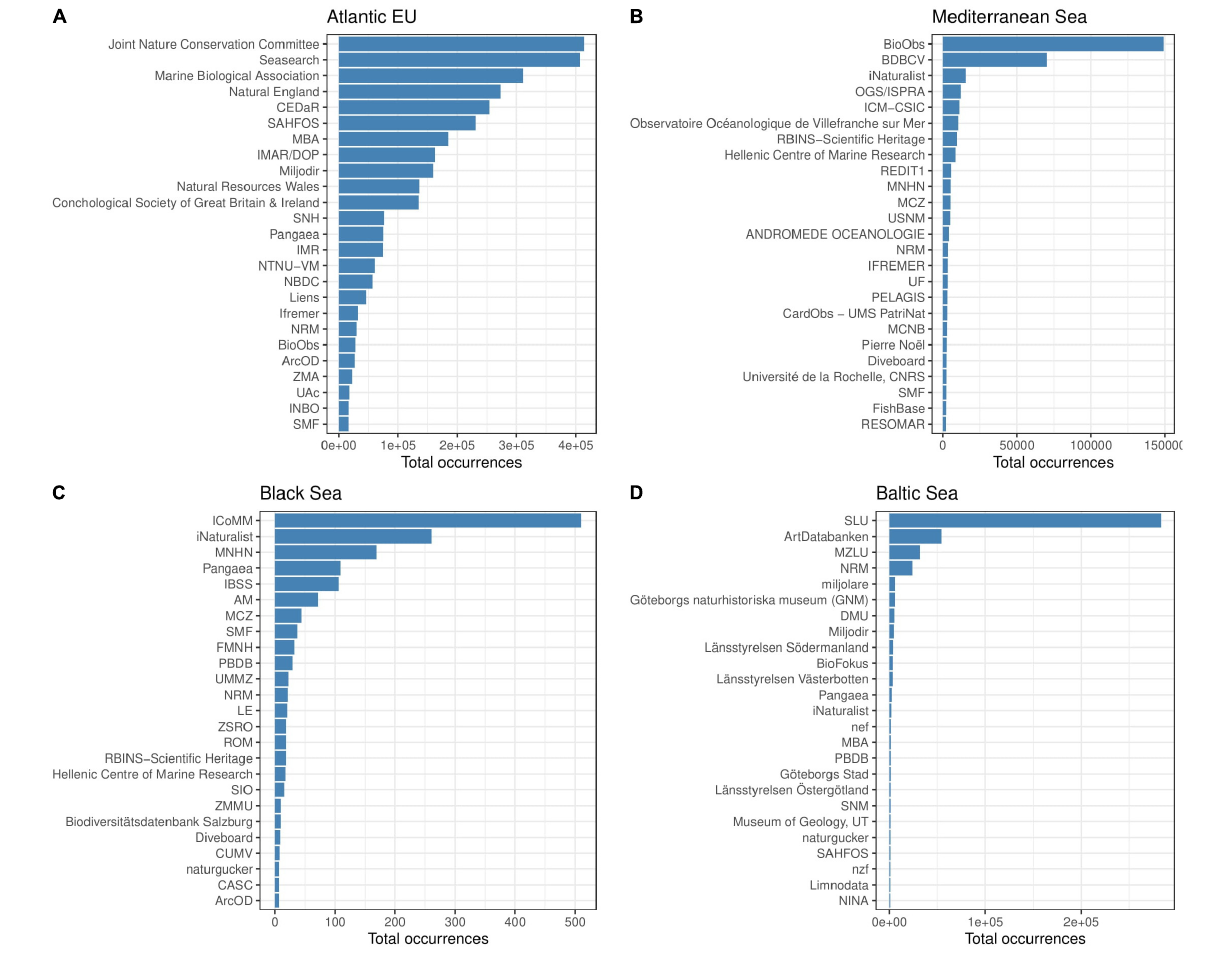
FIGURE 6 | Bar plot showing the total number of occurrences reported by single Institutions for the basins considered in the study. Information on main contributors is provided for the Atlantic EU (A) , Mediterranean Sea (B) , Black Sea (C) , and Baltic Sea (D) . We focused on the top 25 contributors for visualization purposes. However, these top contributors account for most of the reported occurrences (ca. 90% in the Atlantic EU and the Mediterranean Sea, and almost 100% in the Baltic and the Black Seas, see Supplementary Table 2